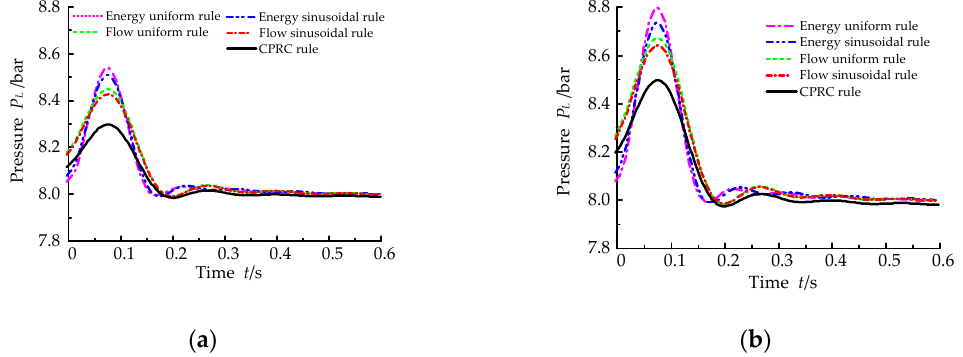
Figure 10. The pressure response curve of the pressure-relief pipe under initial pressures of 100 bar and 150 bar. ( a ) 100 bar initial pressure; ( b ) 150 bar initial pressure.